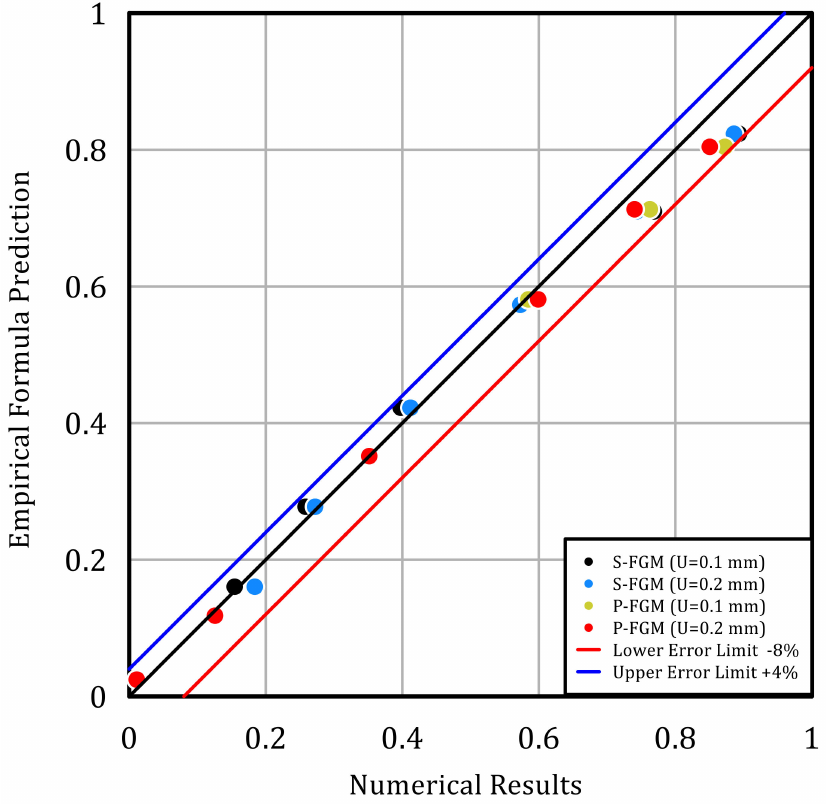
Figure 17. Normalized max permanent penetration depth (empirical) vs. normalized max permanent penetration depth